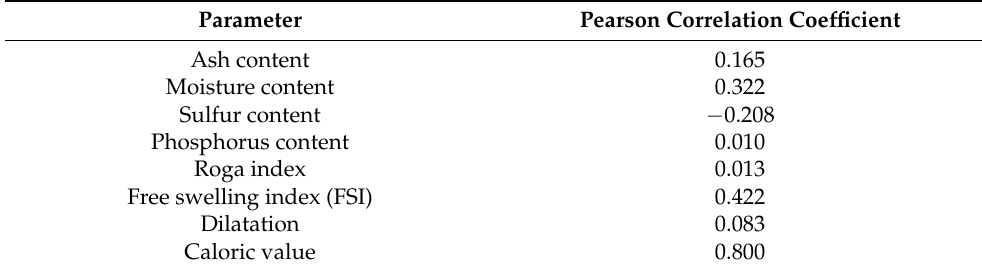
Table 1. Pearson correlation coefficient between selected parameter and Hardgrove